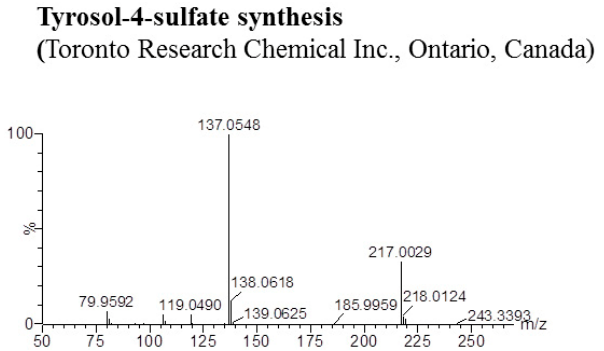
Figure A1. LC-MS anlaysis of synthesized tyrosol-4-sulfate.